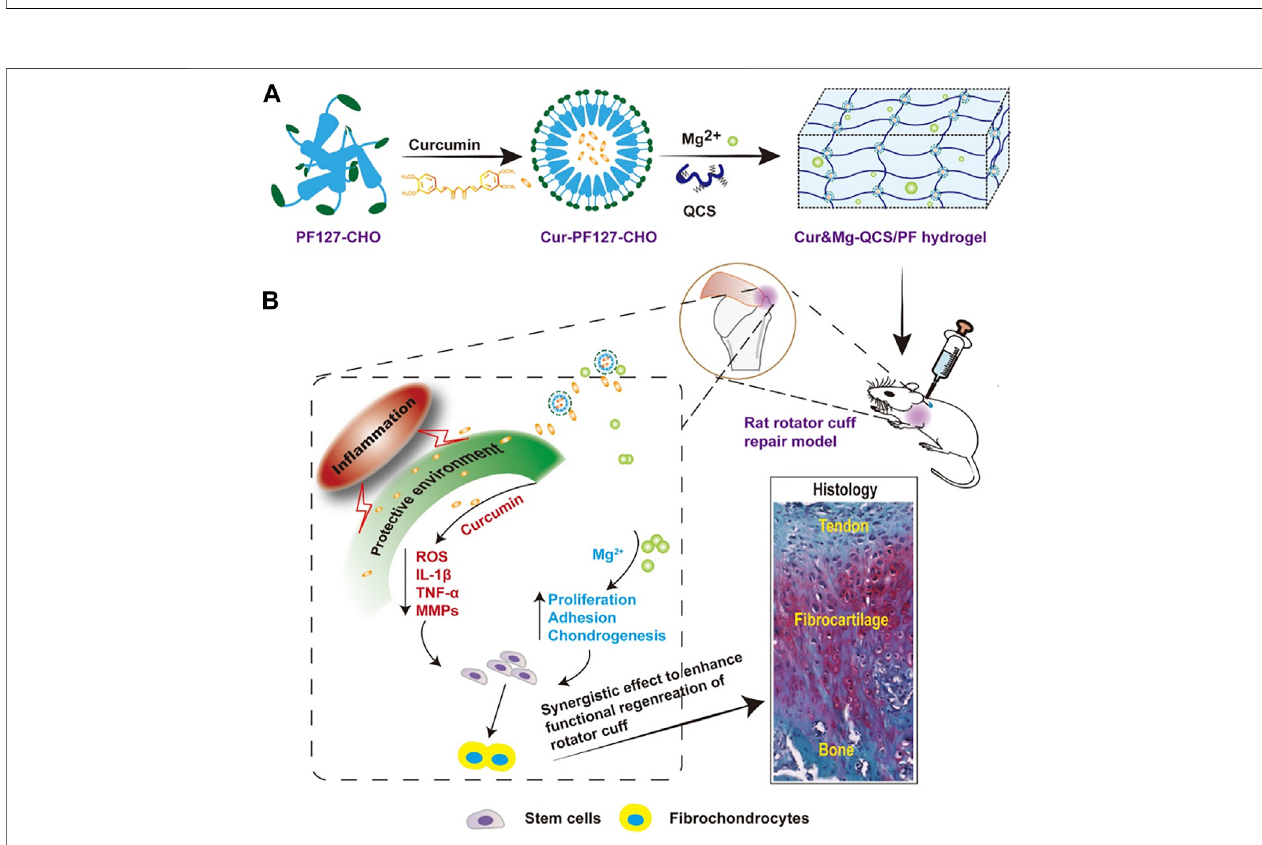
FIGURE 3 | (A) Synthesis of Cur&Mg-QCS/PF hydrogels. (B) In vivo application and evaluation of Cur&Mg-QCS/PF hydrogels. (Reprinted from (Lin et al., 2021) with permission from Theranostics).